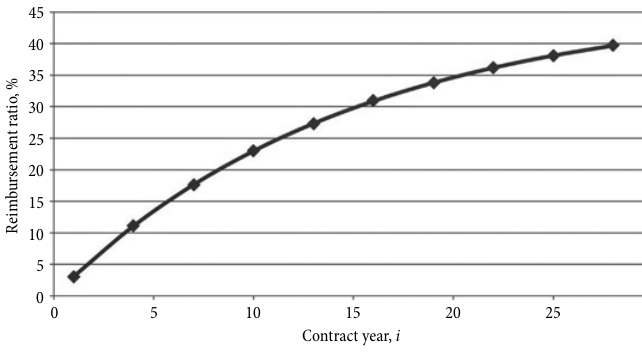
Fig. 6. Sensitivity analysis based on varying contract term